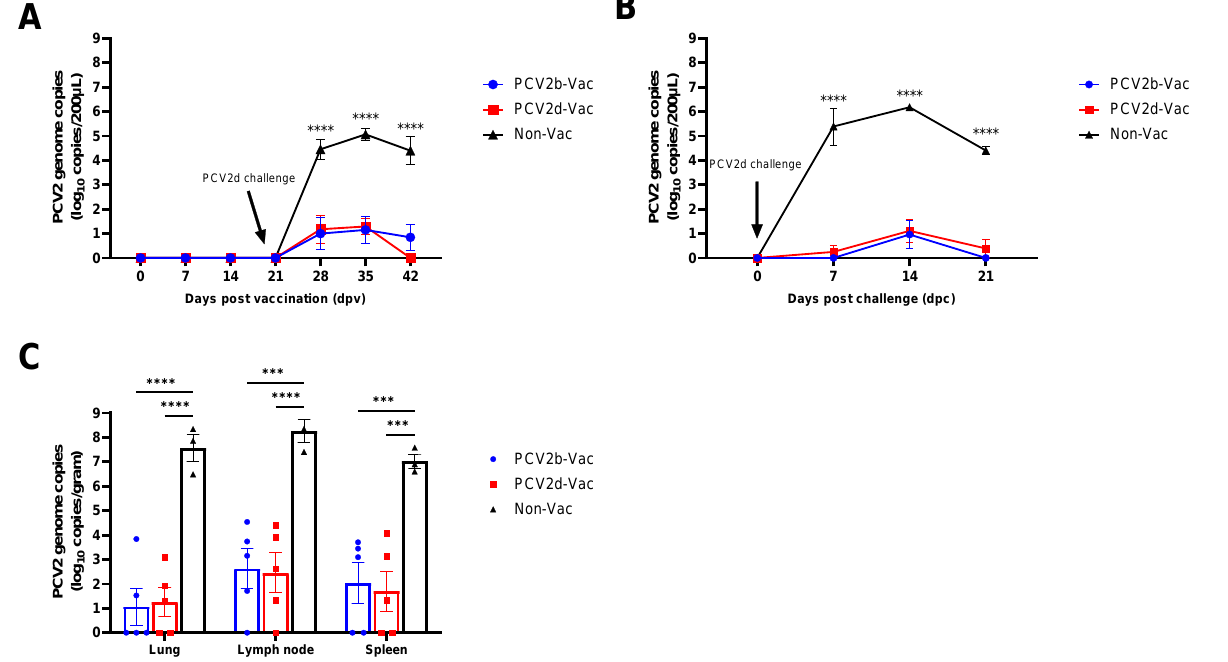
Figure 7. Quantitative PCR analysis of PCV2 genome copies in vaccinated and nonvaccinated pig serum ( A ), nasal swab samples ( B ), and tissue samples ( C ) in the vaccine efficacy study (Experiment 2). The viral DNA copies in the serum and nasal swab samples were detected by quantitative PCR at the indicated timepoints, and those in lung, lymph node, and spleen samples were detected at the time of necropsy. All data are presented as group means ± SEM. Statistically significant differences ( p < 0.001, Tukey’s multiple-comparison test) between Non-Vac and vaccinated groups are indicated at p < 0.001 (***), and p < 0.0001 (****).